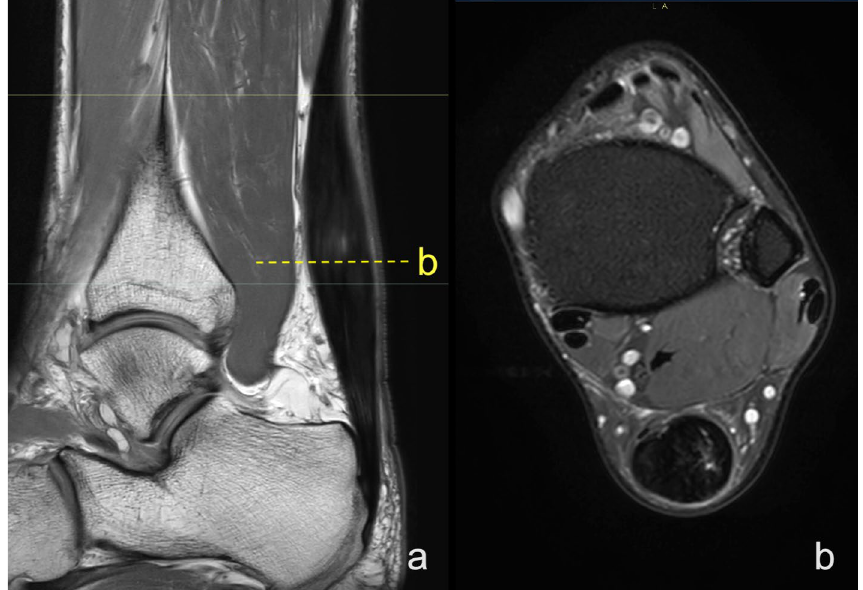
Figure 3. Midportion tendinopathy of the right Achilles tendon in a 45-year-old male who used to run about 3–5 km per day presenting with Achilles pain. Clinical diagnosis of tendinopathy was made with a suspicion of partial rupture. MRI showed a spindle-shaped Achilles tendon with alterations in the signal in the thickened part. ( a )- Sagittal section, PD- weighted TSE, ( b ) axial section PD- weighted SPAIR.